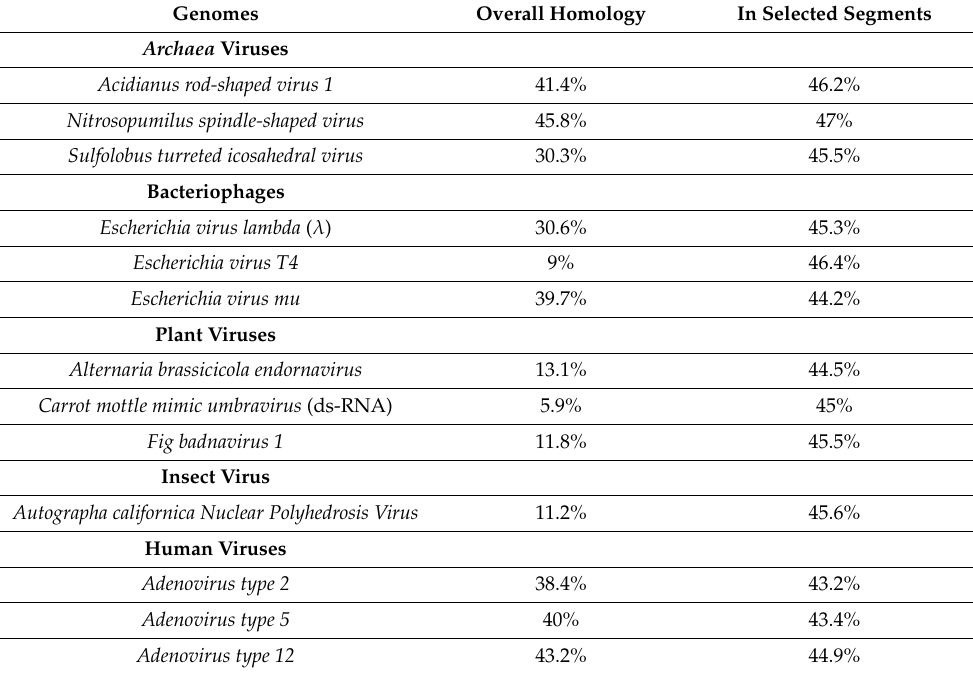
Table 1. Nucleotide sequences that have been compared to the SARS-CoV-2 sequence: percentages of sequence homologies to SARS-CoV-2 . Nucleotide sequences from different viruses, to proteobacteria, bacteria, and to human mitochondrial DNA have been analyzed for sequence homologies, overall or in selected segments, to the SARS-CoV-2